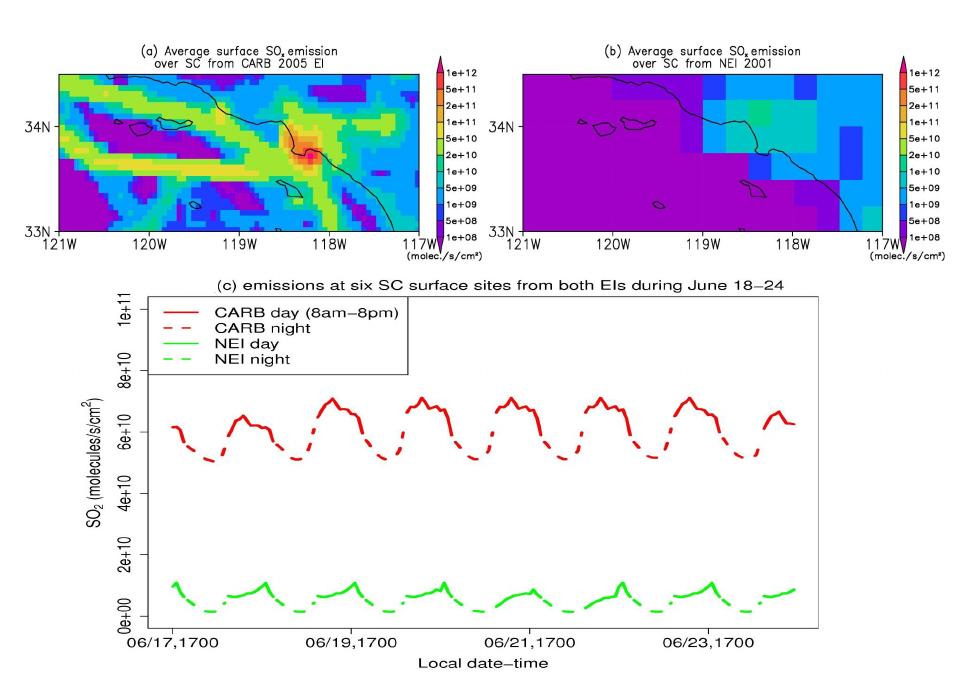
Table 6. Maximum and mean SO x emission rates over California and SC from both EIs and their top emissions sectors. Maximum (kgS/km 2 /day) CARB Statewide